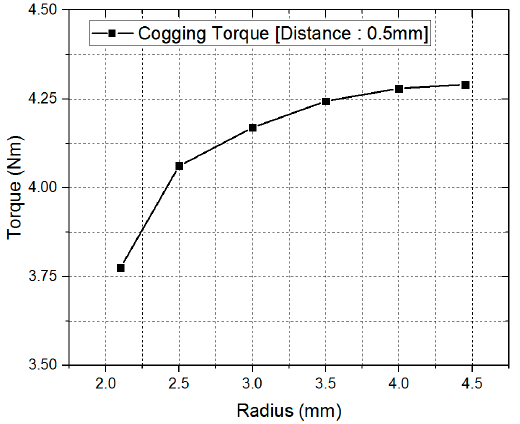
Figure 9. Comparative analysis of cogging torque when notch shape distance (1) is 0.5 mm.